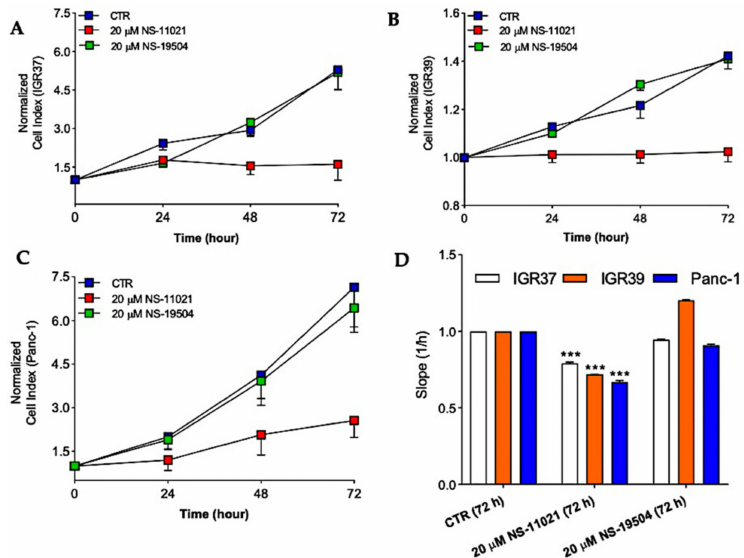
Figure 7. Real-time cell proliferation, monitored by the xCELLigence RTCA DP Instrument. Cell index (CI) curves of cellular proliferation of ( A ) IGR37, ( B ) IGR39, and ( C ) Panc-1 obtained after treatment for 72 h with 20 µ M NS-11021 or NS-19504. ( D ) Cell proliferation has also been quantified by the slope of curves (CI) calculated by RTCA 1.2 software. The 0.1% DMSO (maximal percentage used in the treatments) had no obvious cytotoxicity. *** p < 0.001 versus control as determined by one-way ANOVA followed by Dunnet’s post hoc test ( n =